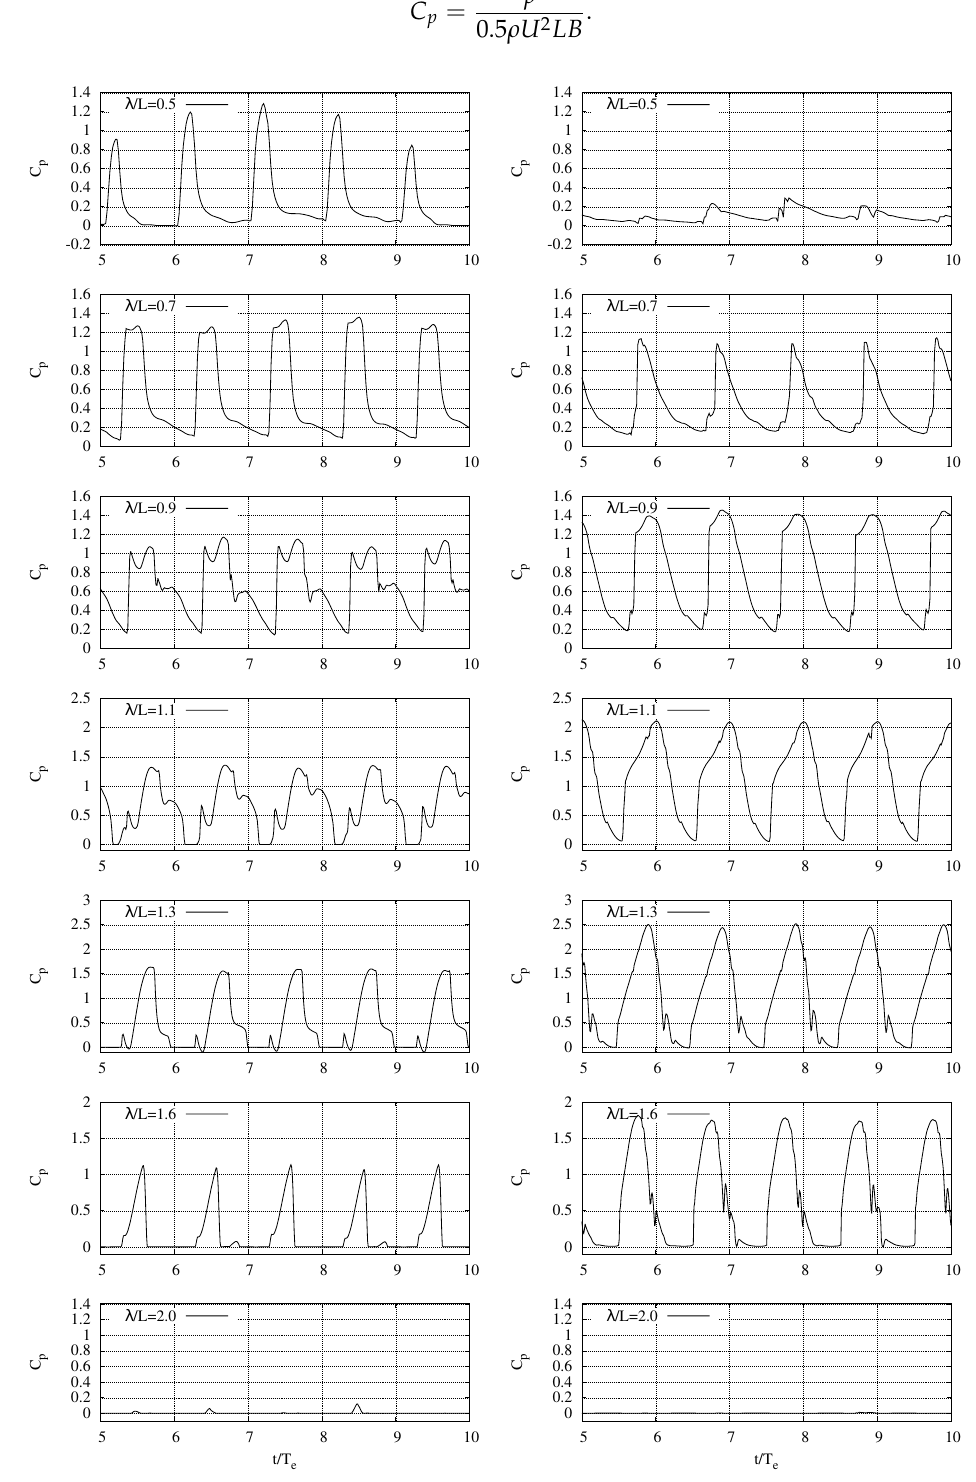
Figure 9. Time histories of the pressure coefficients at point 1 (left column) and point 2 (right